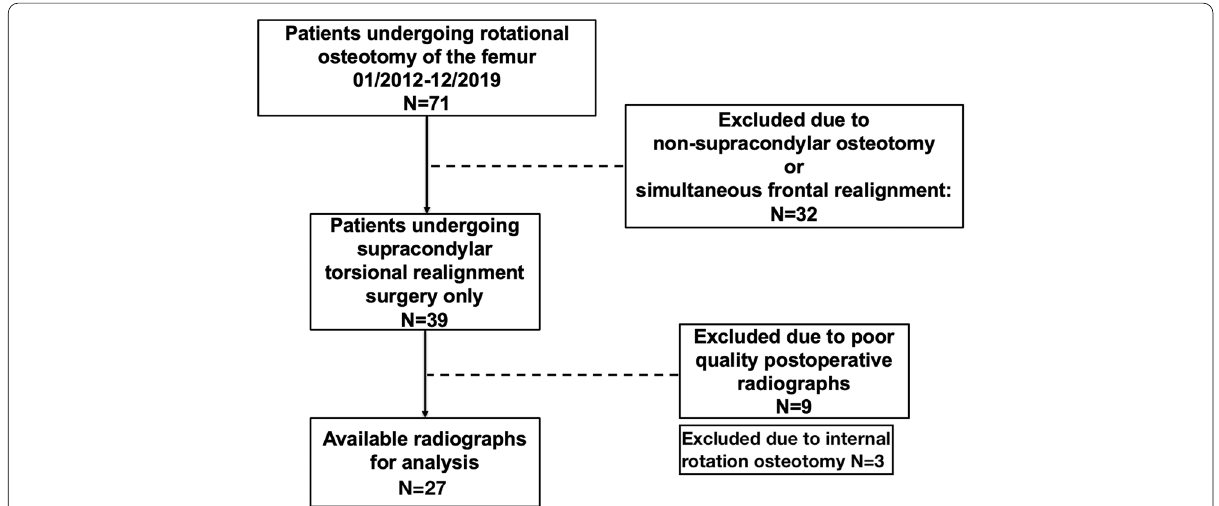
Fig. 1 Flowchart demonstrating